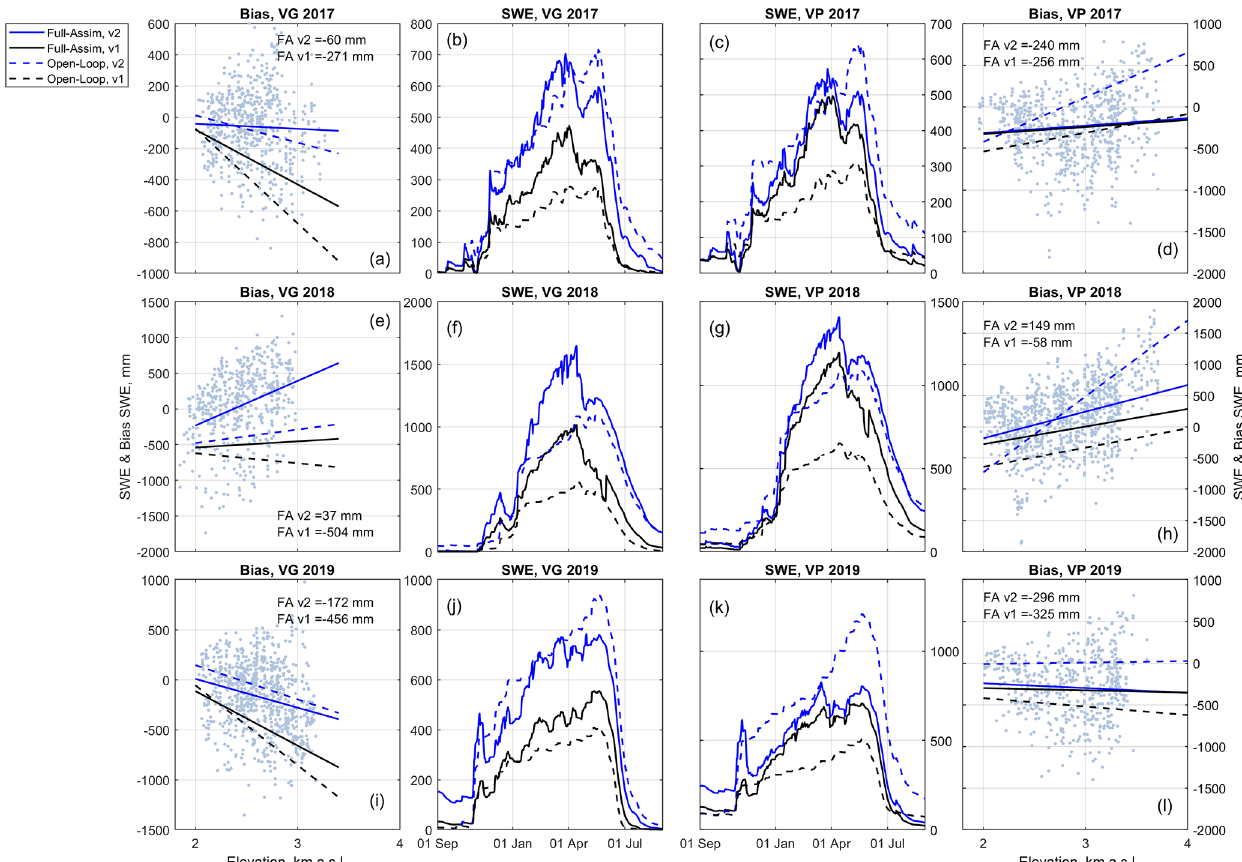
Figure 9. Evaluation of Flood-PROOFS simulations of snow water equivalent (SWE) driven by GRISO1 vs. those driven by GRISO2 (v1 and v2, respectively). (a, e, i) Orographic trends of model bias with respect to snow-course-measured SWE at Beauregard (VG). (d, h, l) A similar comparison at Valpelline (VP). Panels (b–c) , (f–g) , and (j–k) compare simulated SWE using both GRISO1 or GRISO2. Simulations were carried out both in OL and in Full-Assim mode (see Sect.